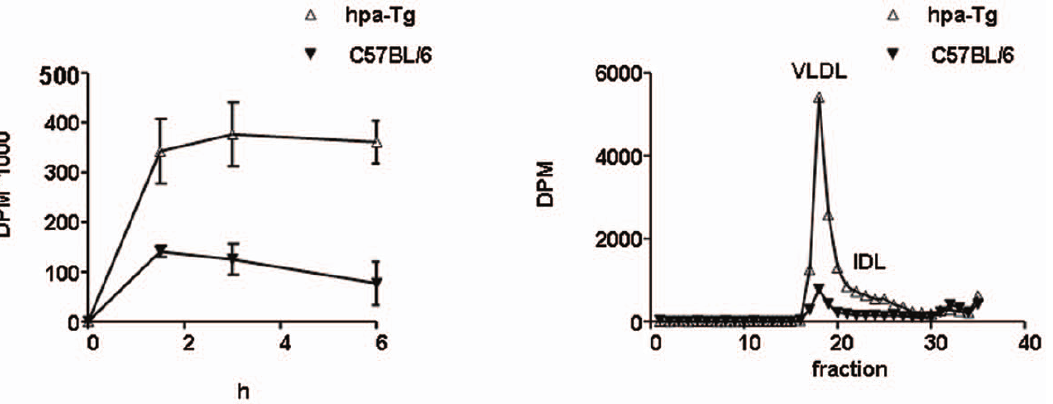
Figure 3. 3 H-retinol accumulation (A) and distribution (B) in plasma following oral administration. (A) Mice were fasted overnight and then administered a bolus of 100 m l corn oil containing 3 H-retinol via a stomach tube. Radioactivity in plasma of hpa-Tg mice (n=3) was significantly higher compared to C57BL/6 (n=3) during the 6 h following retinol administration (p , 0.01). (B) 200 m l of plasma from hpa-Tg and C57BL/6 mice, taken 3 h following retinol load were analyzed by FPLC. As indicated in the figure, retinol radioactivity was increased in the VLDL and IDL fractions of